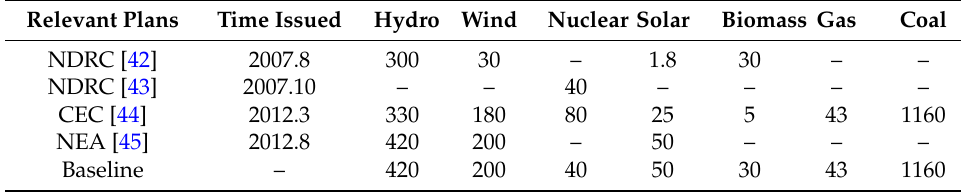
Table 3. Installed capacity in related plans and the baseline power planning scenario in China in 2020 (GW).